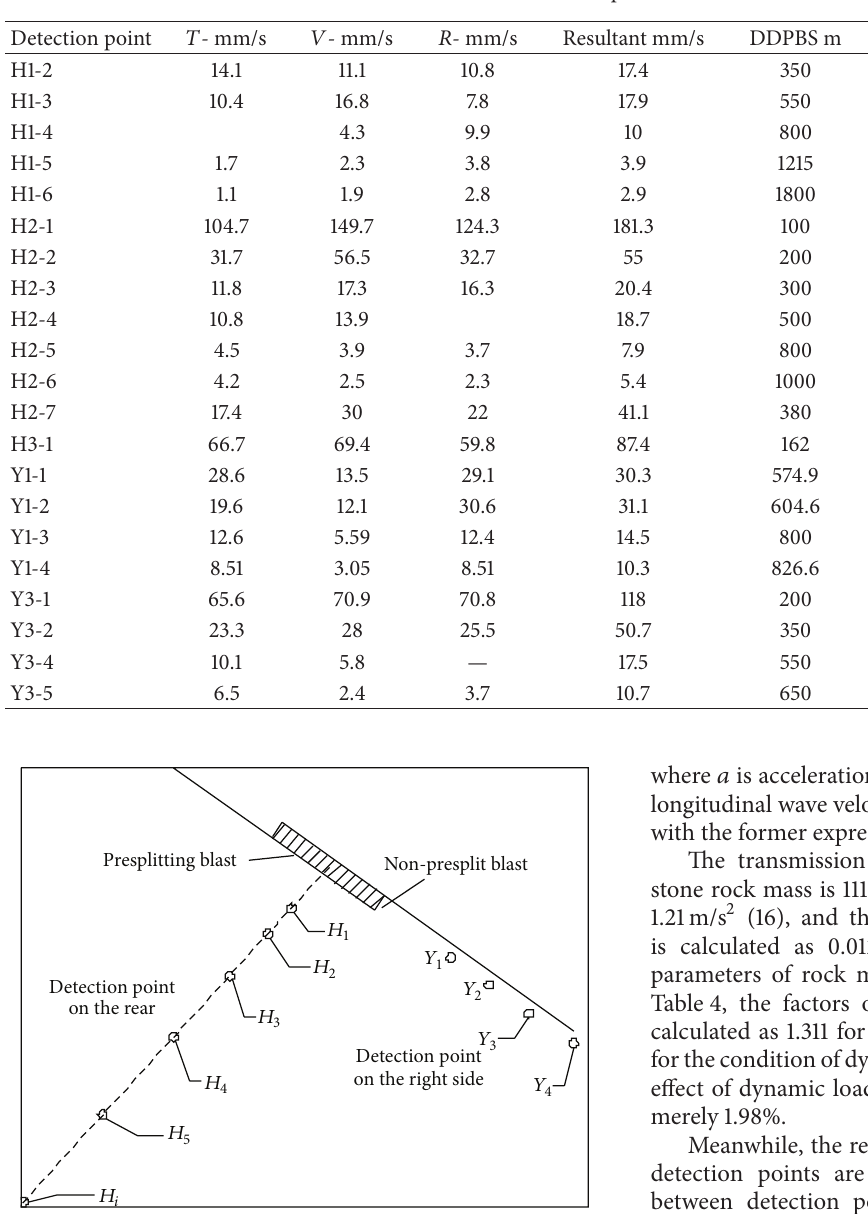
Figure 8: Location of the blast detection point and blast vibration